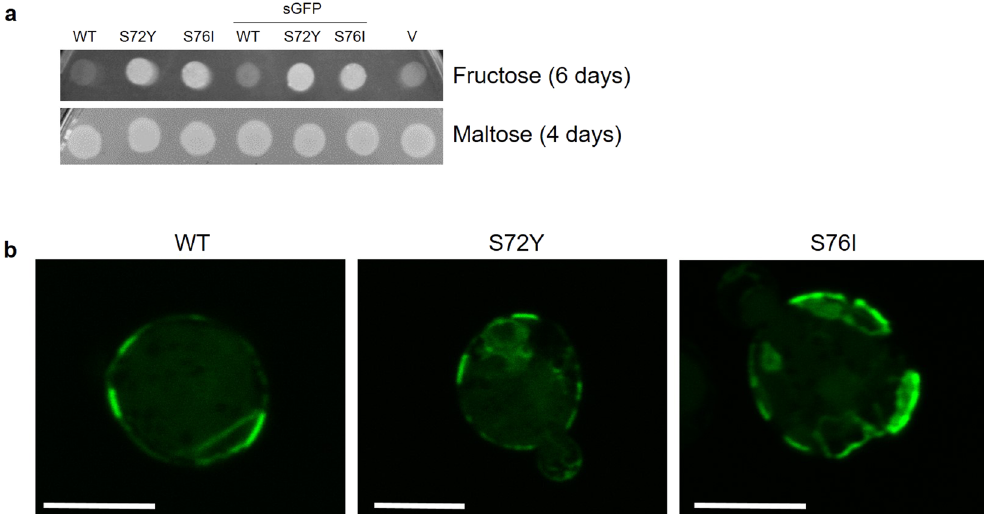
Figure 1. Functionality and subcellular distribution of GLUT5 variants. ( a ) Suspensions of EBY.VW4000 cells (OD 600nm = 1) transformed with plasmids encoding GLUT5tr, GLUT5tr S72Y , GLUT5tr S76I or their fusions with sGFP were droped onto agar plates containing 2% (w/v) fructose (SCF-Ura-Met medium) or 1% (w/v) maltose (SCM-Ura medium). The latter medium was used to control the viability of the transformants and empty vector (V) was a negative control for growth on fructose. The duration of incubation at 30 °C is indicated. ( b ) The cells expressing the indicated variant of GLUT5-sGFP fusion proteins were cultivated in SCM-Ura-Met media until the exponential phase and analyzed by confocal laser scanning microscopy. Scale bar, 5 µ